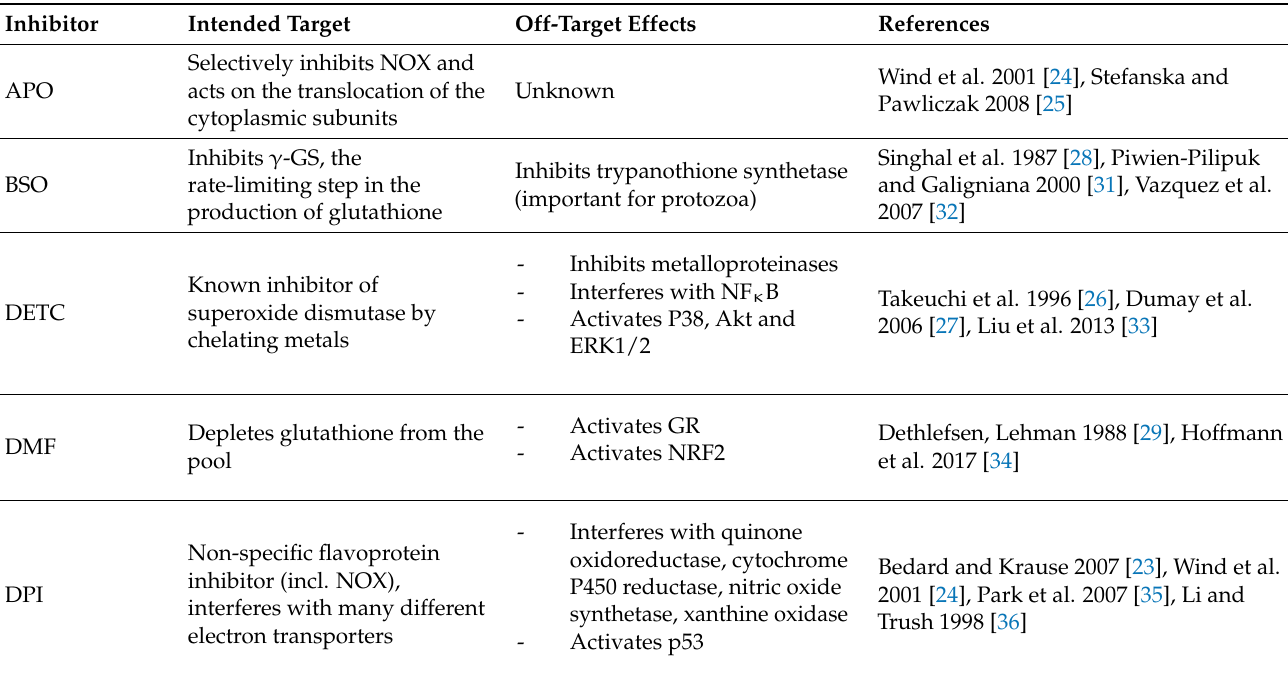
Table 1. Inhibitors used in this study to interfere with the redox balance, their aimed targets and known off-target effects. Inhibitor Intended